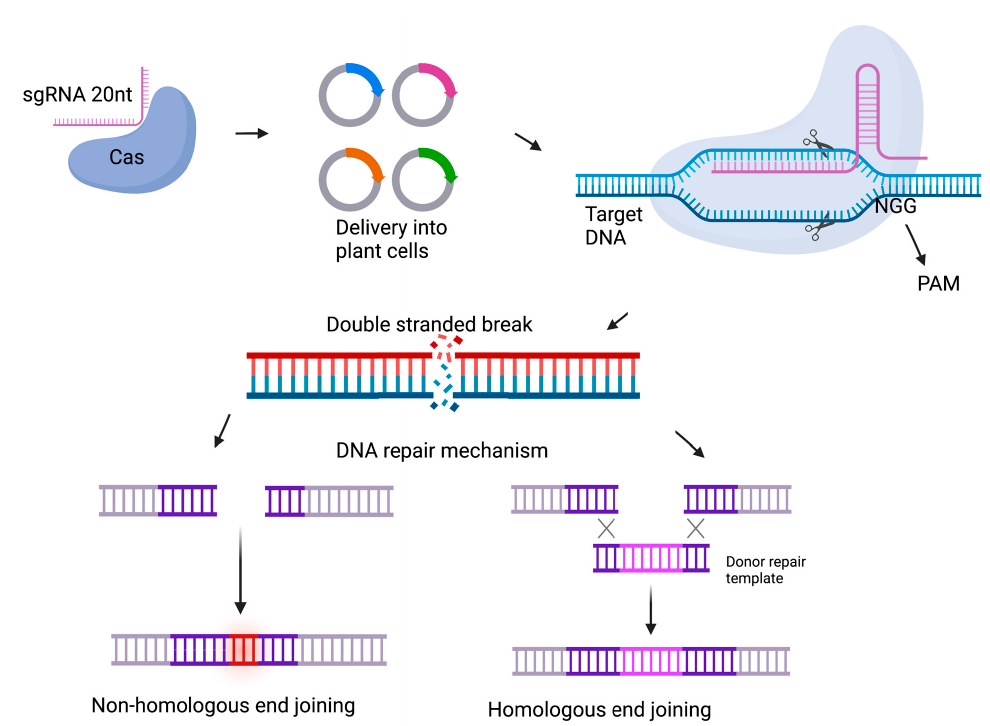
Figure 4. Schematic representation of the CRISPR/Cas9 genome editing mechanism in plant cells. Created with BioRender.com. (Accessed 11 January 2023).